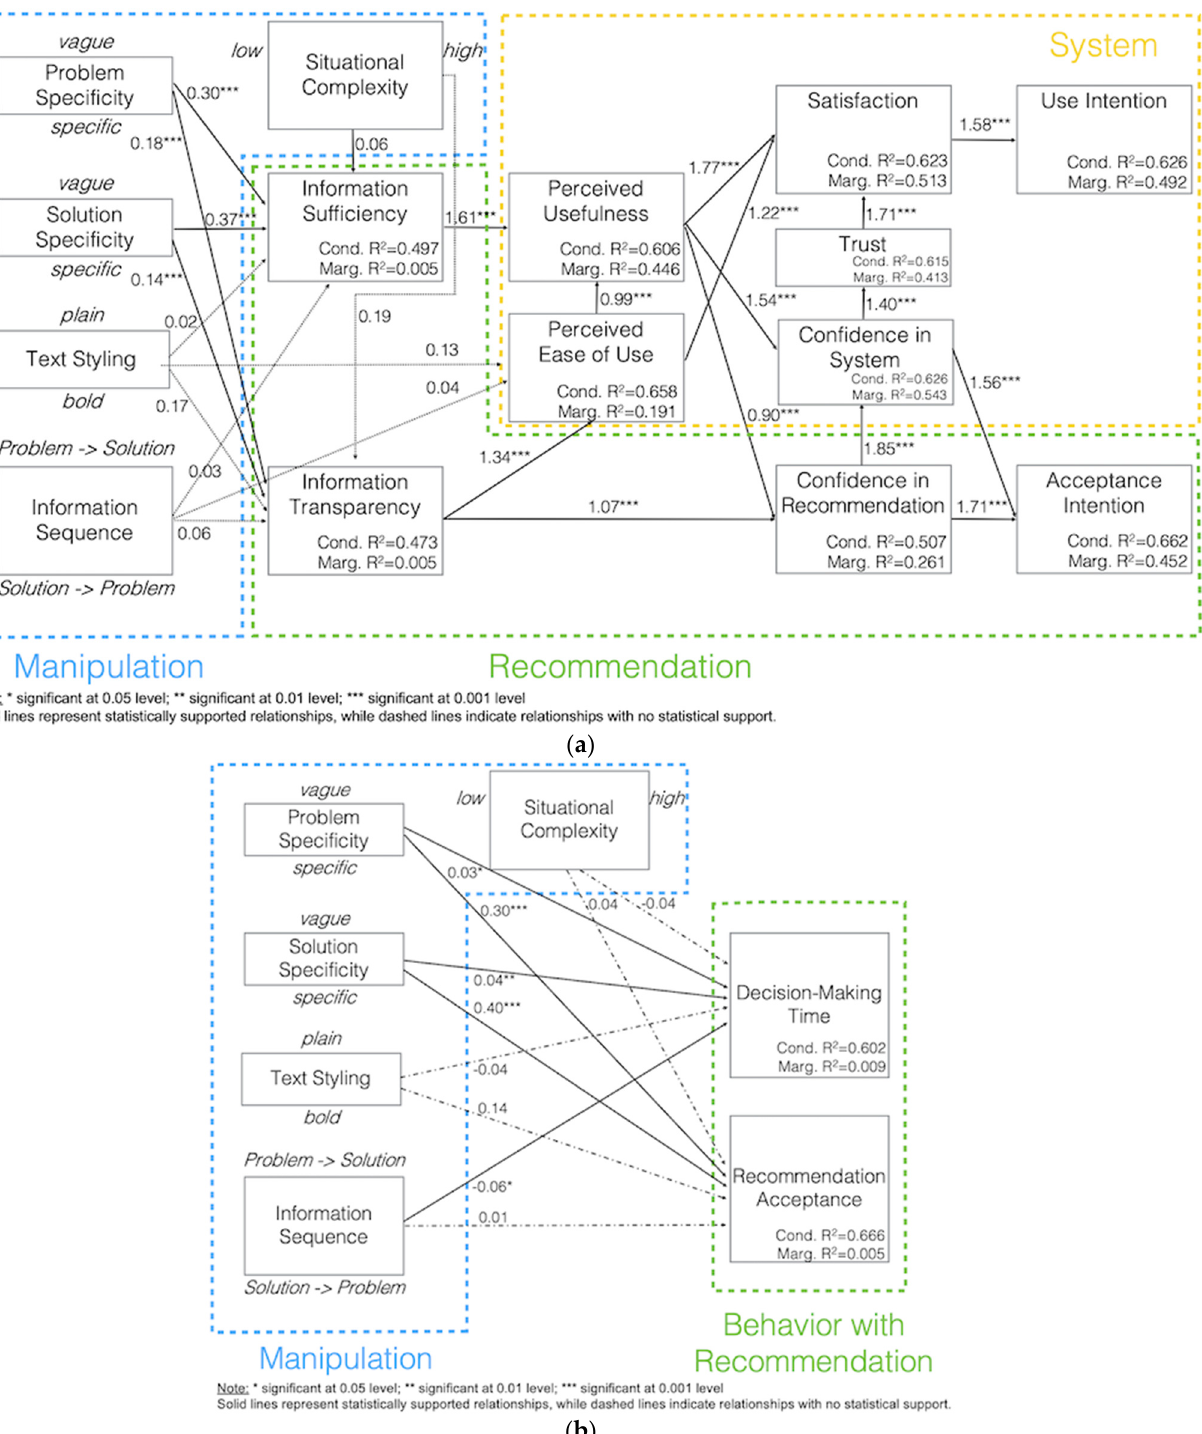
Figure 5. ( a ) Validated research model (self-reported data); ( b ) Validated research model (behavioral data). Table 3. Summary table of all the hypotheses and their results.